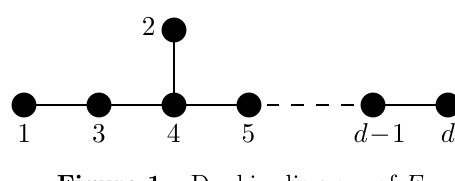
Figure 1 . Dynkin diagram of E d